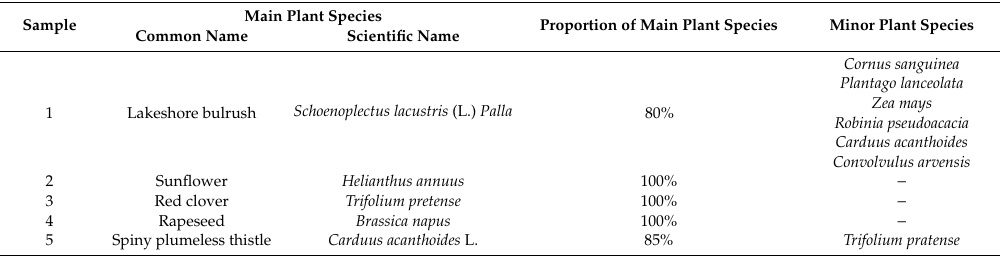
Table 1. Results of the microscopic pollen